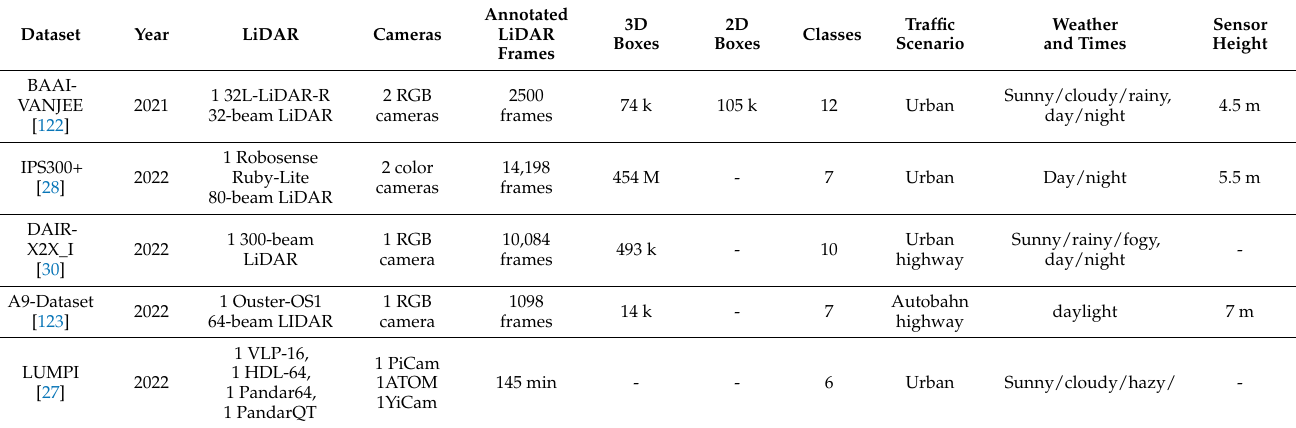
Table 5. Survey of datasets recorded by infrastructure